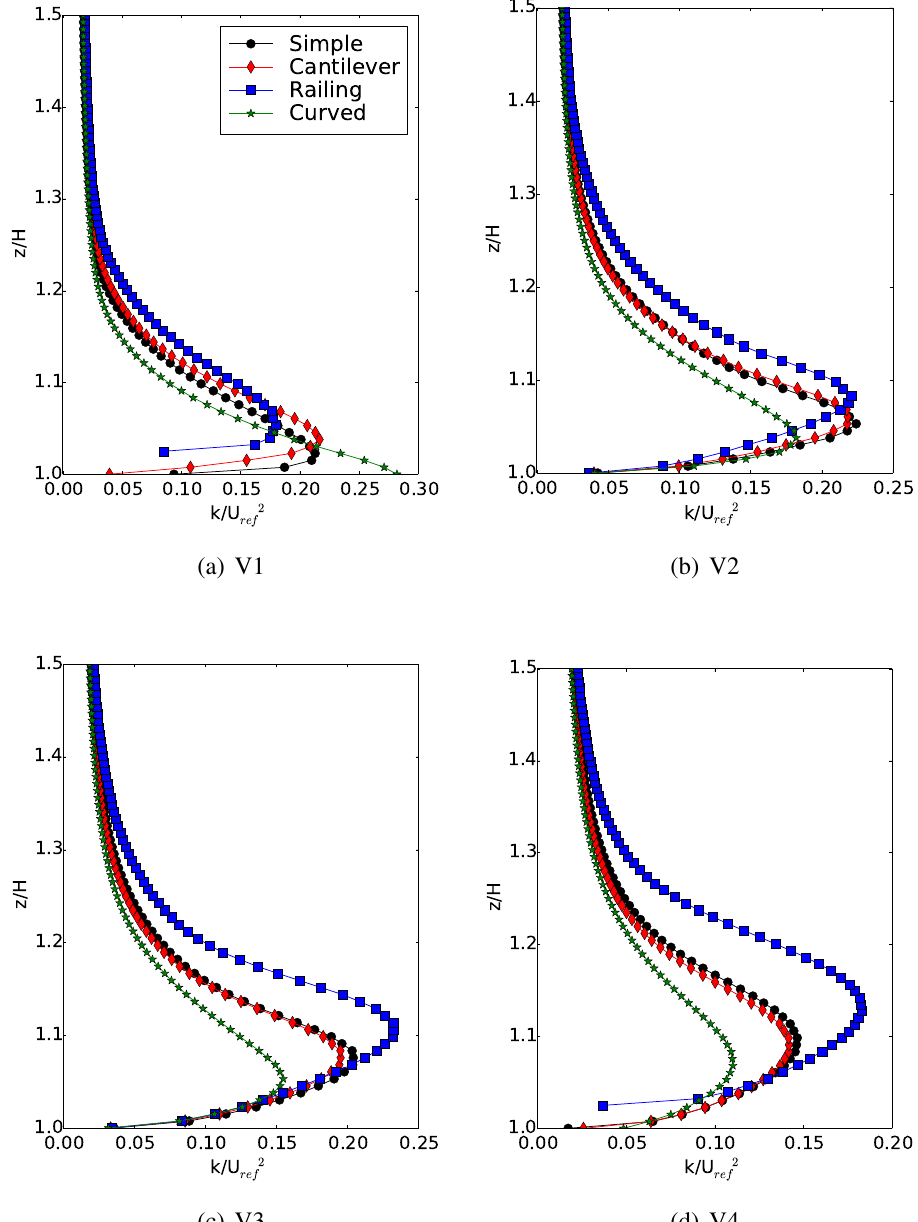
Figure 19. Comparison of k between the different roof edge shapes investigated at the vertical section at the center of the